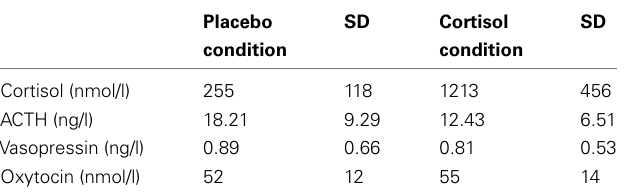
Table 1 | Mean plasma hormone levels (SD) per condition (placebo vs. cortisol treatment).